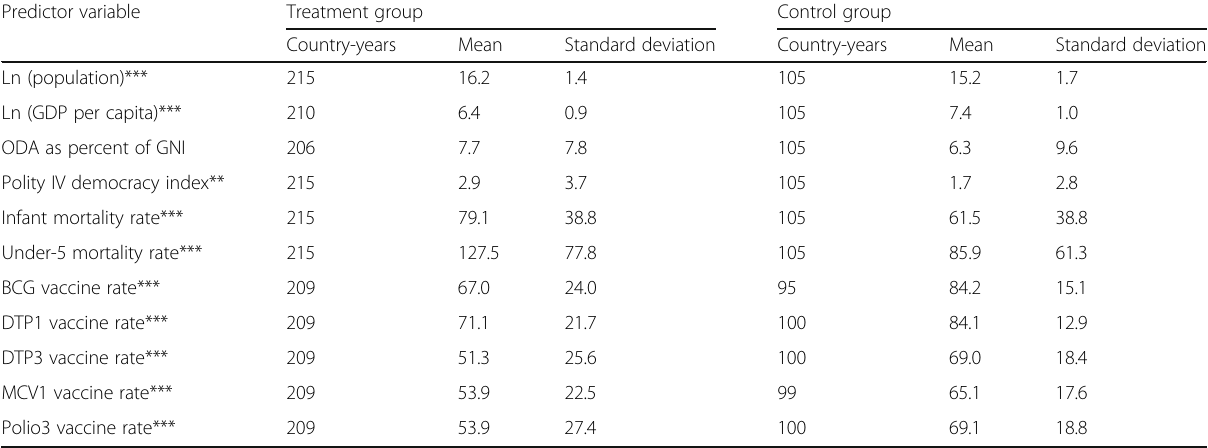
Table 3 Descriptive statistics by group for synthetic control method predictor variables from 1985 to 1989 Predictor